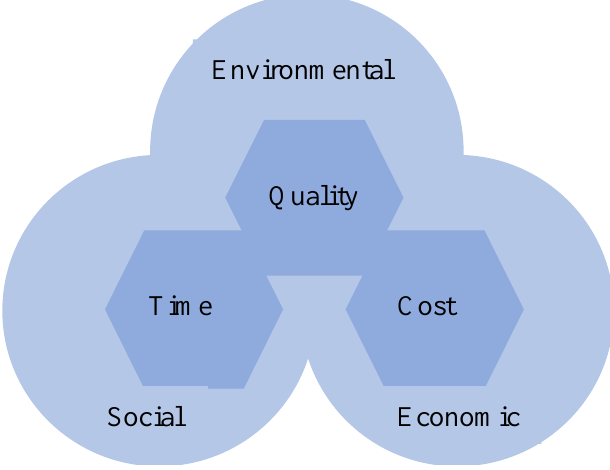
Figure 4. Industry vs. Sustainability Pillars.